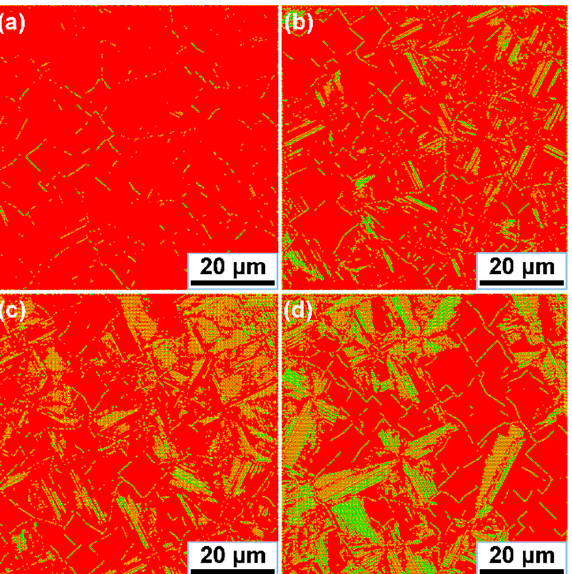
Figure 9. Simulation results of α -Mg/ β 1 -Mg 3 Nd eutectic morphologies for Mg–Nd system alloys: ( a ) Mg-4Nd; ( b ) Mg-5Nd ( c ) Mg-6Nd; ( d ) Mg-7Nd.